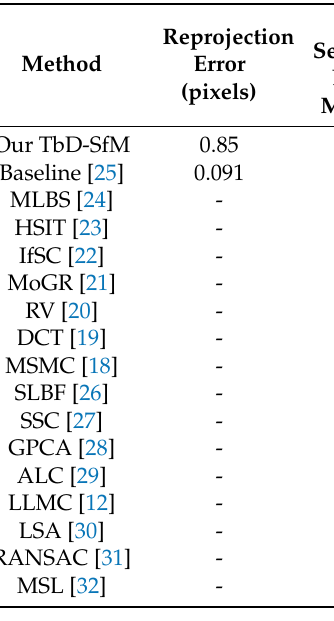
Table 10. TbD-SfM results compared with other methods for Hopkins dataset car